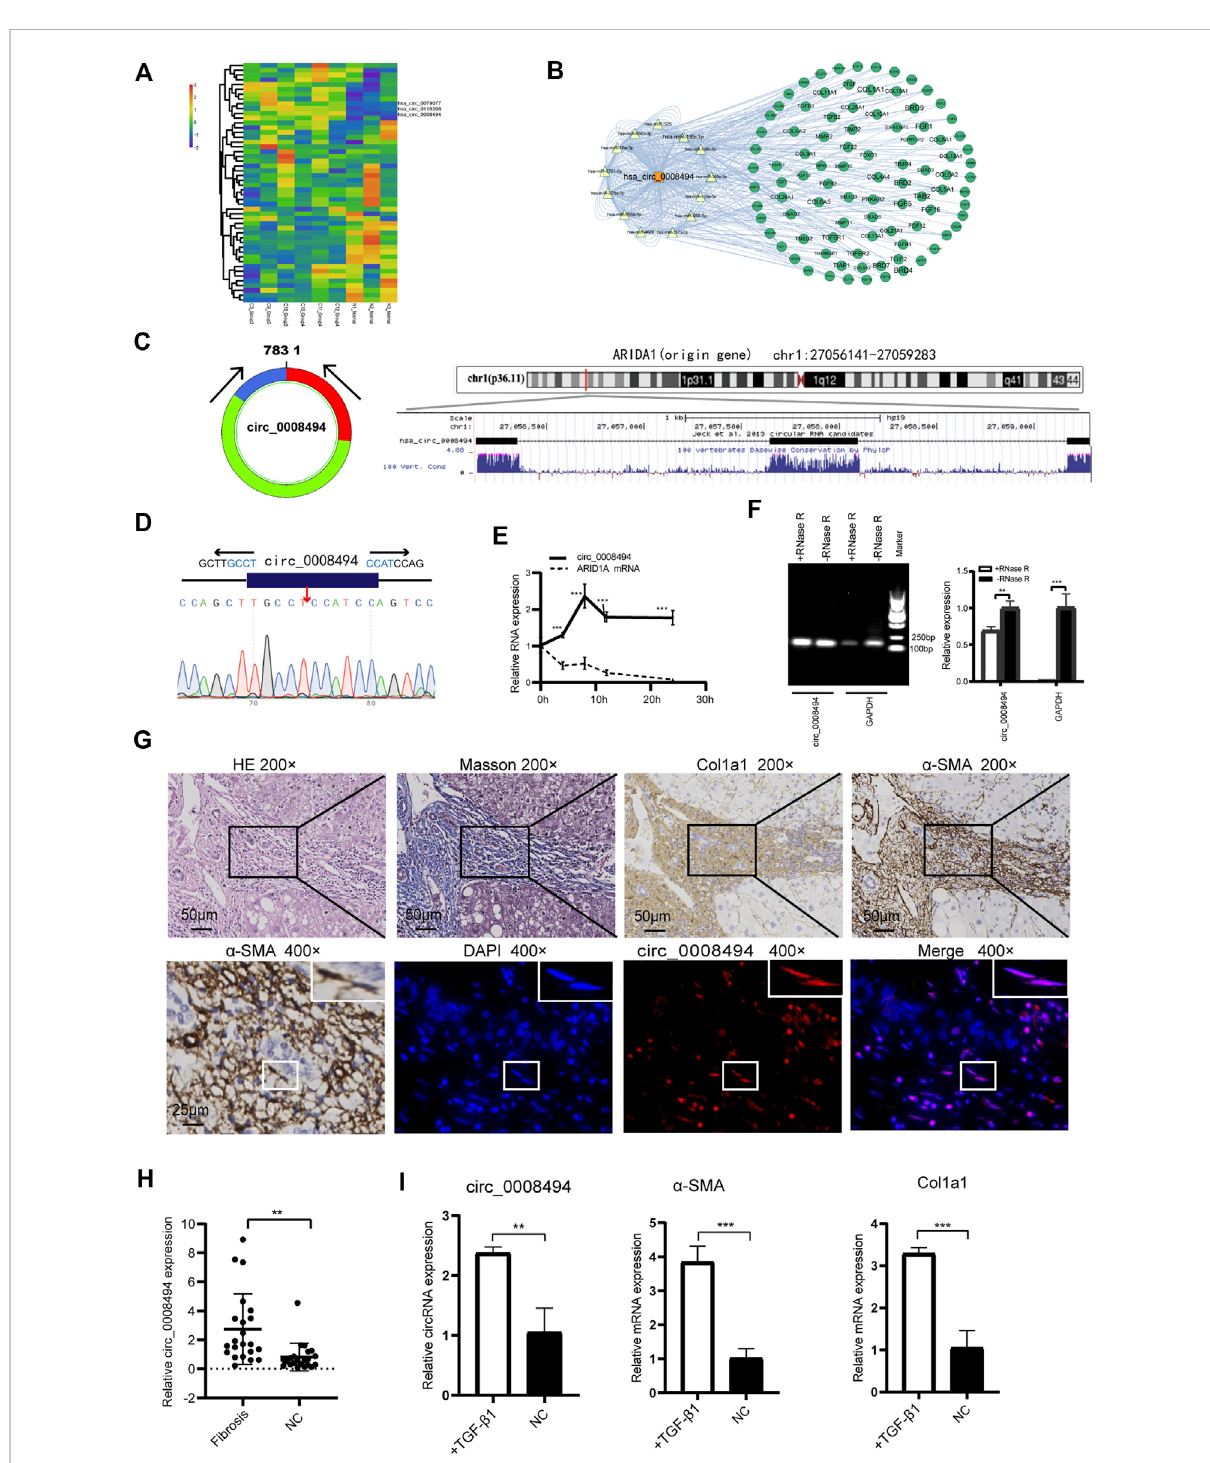
FIGURE 2 Identi fi cation and characteristics of circ_0008494 in HF tissues and HSCs (A) circRNAs clustering heat map showed circ_0008494 was up- regulated in HF tissues. C represents HF samples ( n = 6). N represents control samples ( n = 3). High expression level is indicated by “ red ” and lower levels by “ blue ” (B) circRNA-miRNA-mRNA interaction network of circ_0008494 (C) circ_0008494 is derived from the second, third and fourth exons of the ARIDIA gene, which is located on chromosome 1p36 (D) The back-splice junction of circ_0008494 was veri fi ed by Sanger sequencing (E) ActD treatment assay showed circ_0008494 was more stable and resistant to ActD than the linear ARID1A mRNA (F) Electrophoresis on agarose gel and qRT-PCR assays showed circ_0008494 exhibited clear resistance to RNase R digestion (G) FISH assay was conducted on the